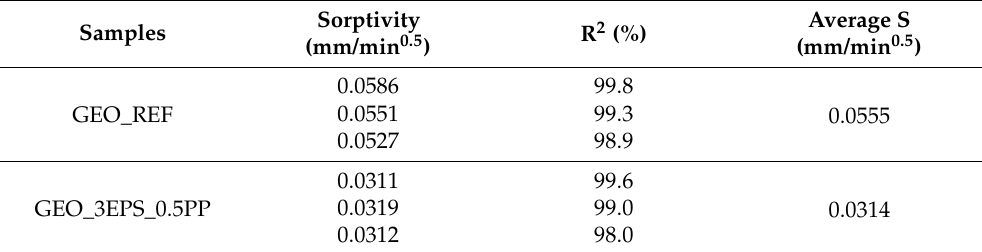
Table 6. Sorptivity and R 2 values of tested